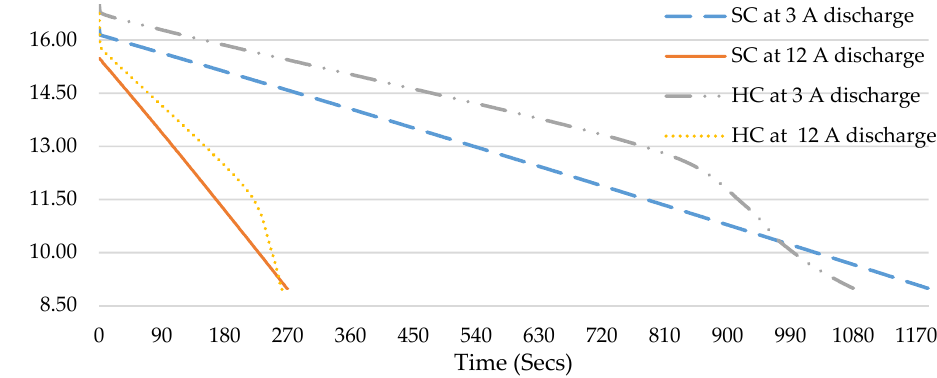
Figure 8. The experimental validation of the SC and HC banks showing the discharging curves under a 3-A and a 12-A load.